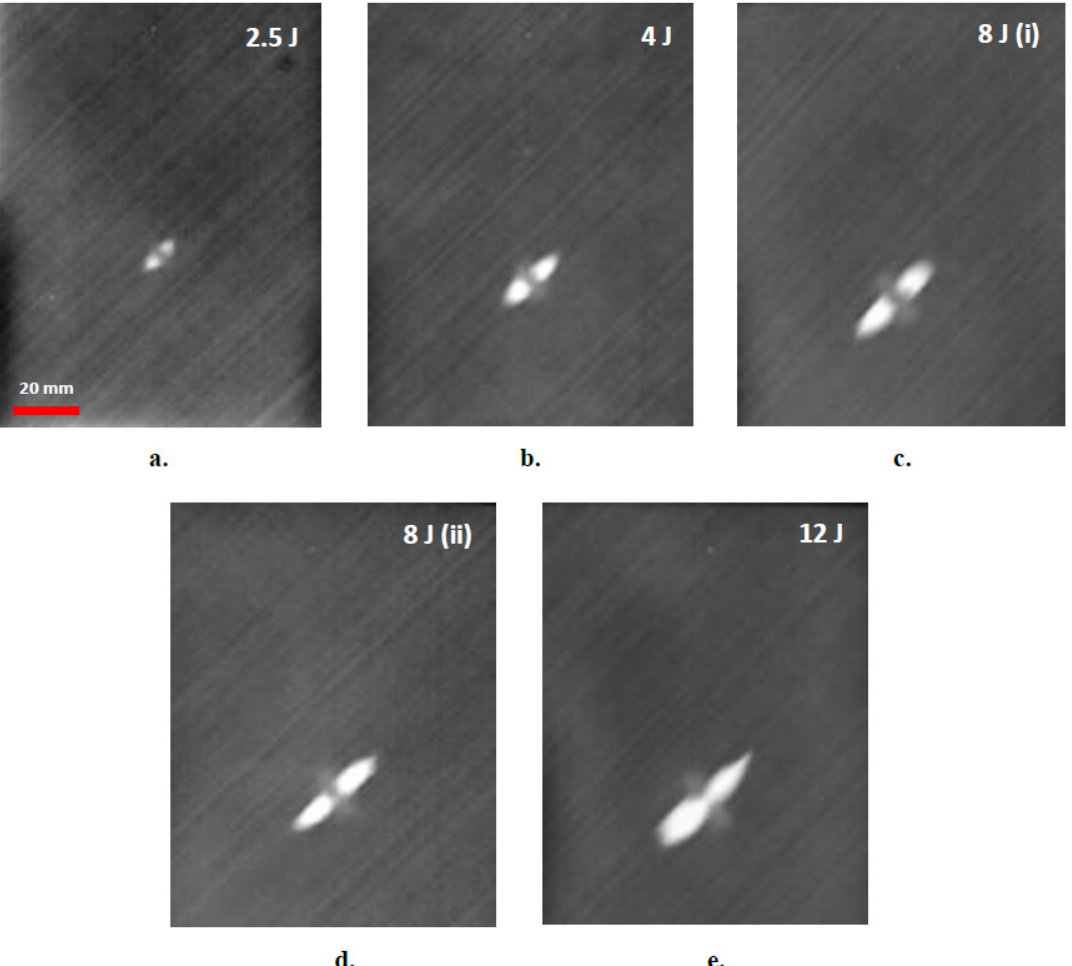
Figure 5. Thermographic assessment of impact damage in thin, 9-layer composite laminates for di ff erent levels of impact energies. ( a ) 2.5 J, ( b ) 4 J, ( c ) 8 J, ( d ) 8 J, ( e ) 12 J.